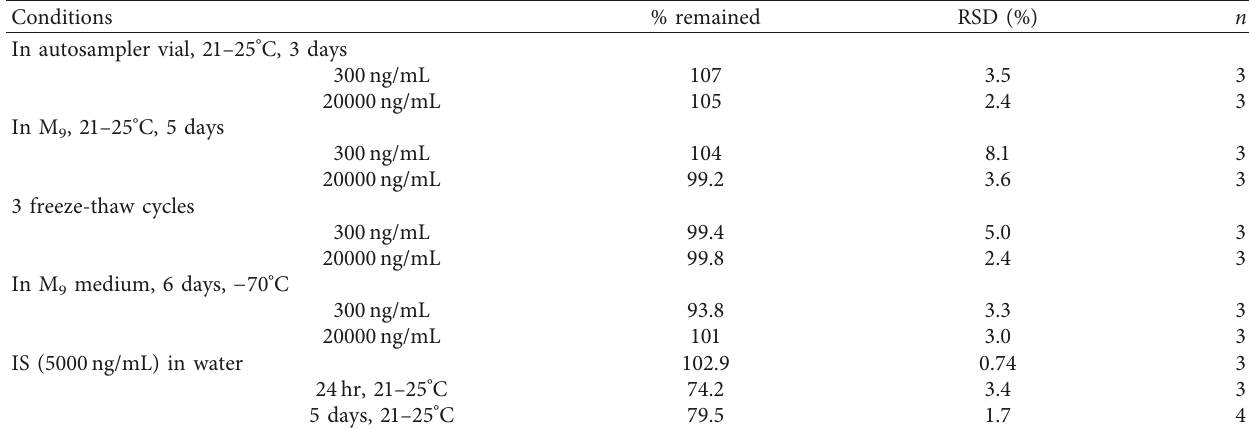
Table 4: Stability of TBM.